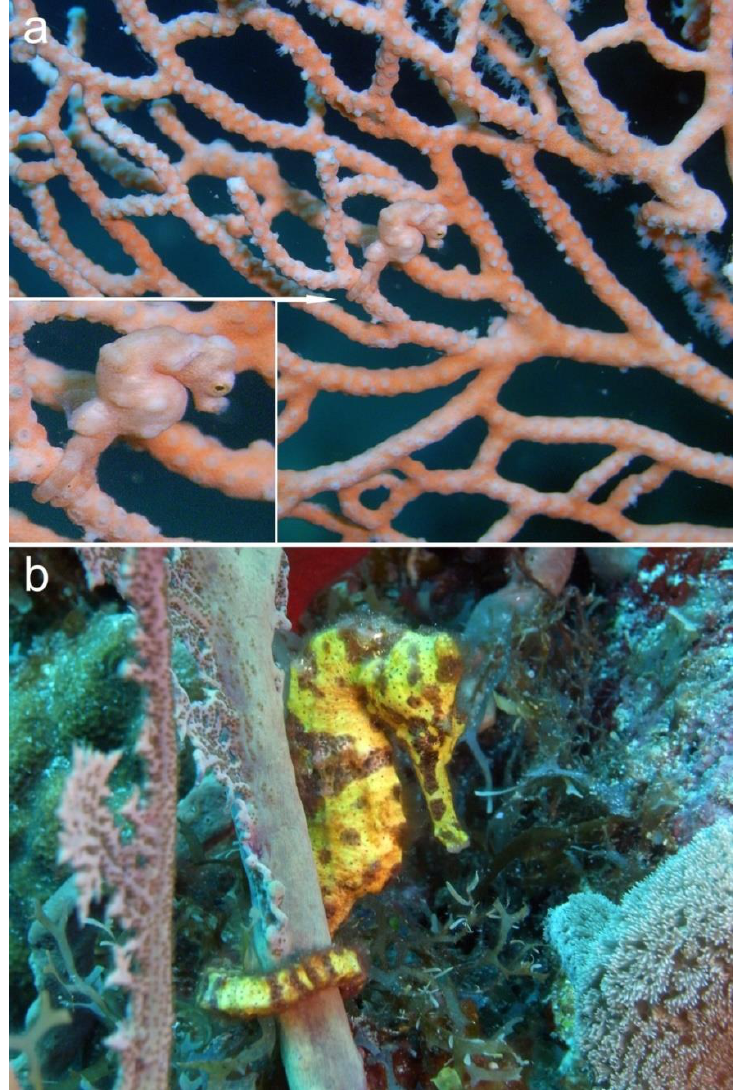
Figure 3. Two Hippocampus individuals clinging to gorgonian octocorals in their natural environment: ( a ) H. denise at Raja Ampat Islands, West Papua, Indonesia (2006); ( b ) H. reidi at St. Eustatius, Eastern Caribbean (2015). Photo credit: B.W. Hoeksema.